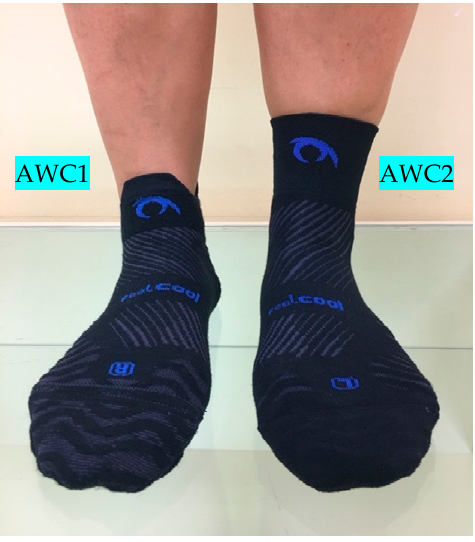
Figure 2. Subject with the two models of sock, the AWC 2.1 on the left foot and the AWC 1 on the right.